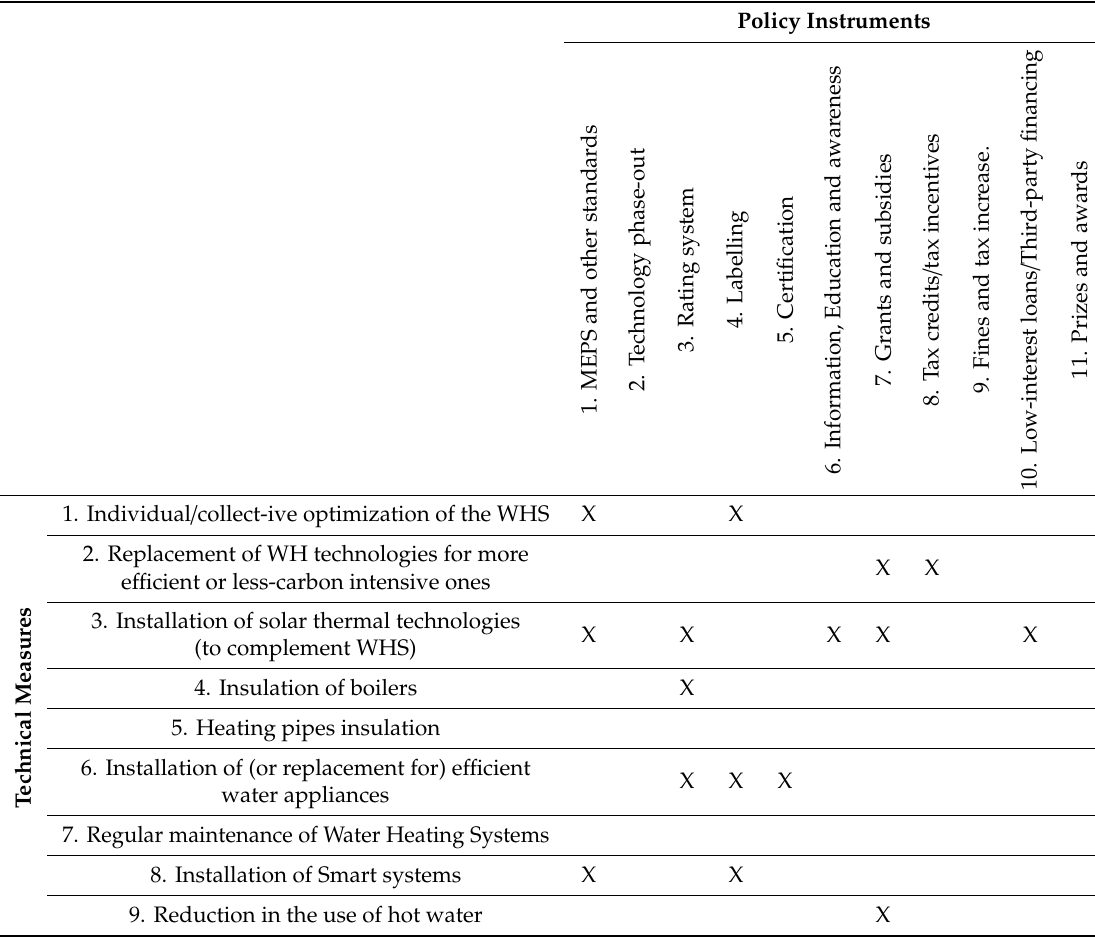
Table 6. Combination of technical measures and policy instruments identified in the literature